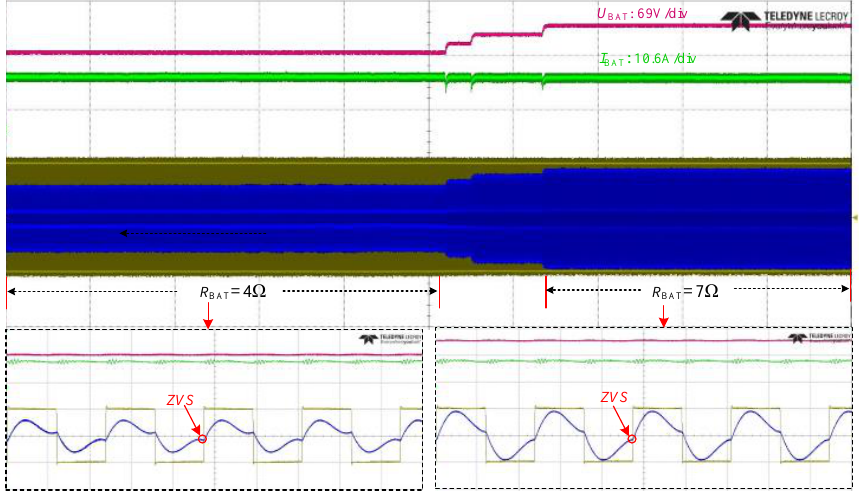
Figure 16. Experimental waveforms of U BAT , I BAT , U IN , and I IN in the DS-LCC topology.